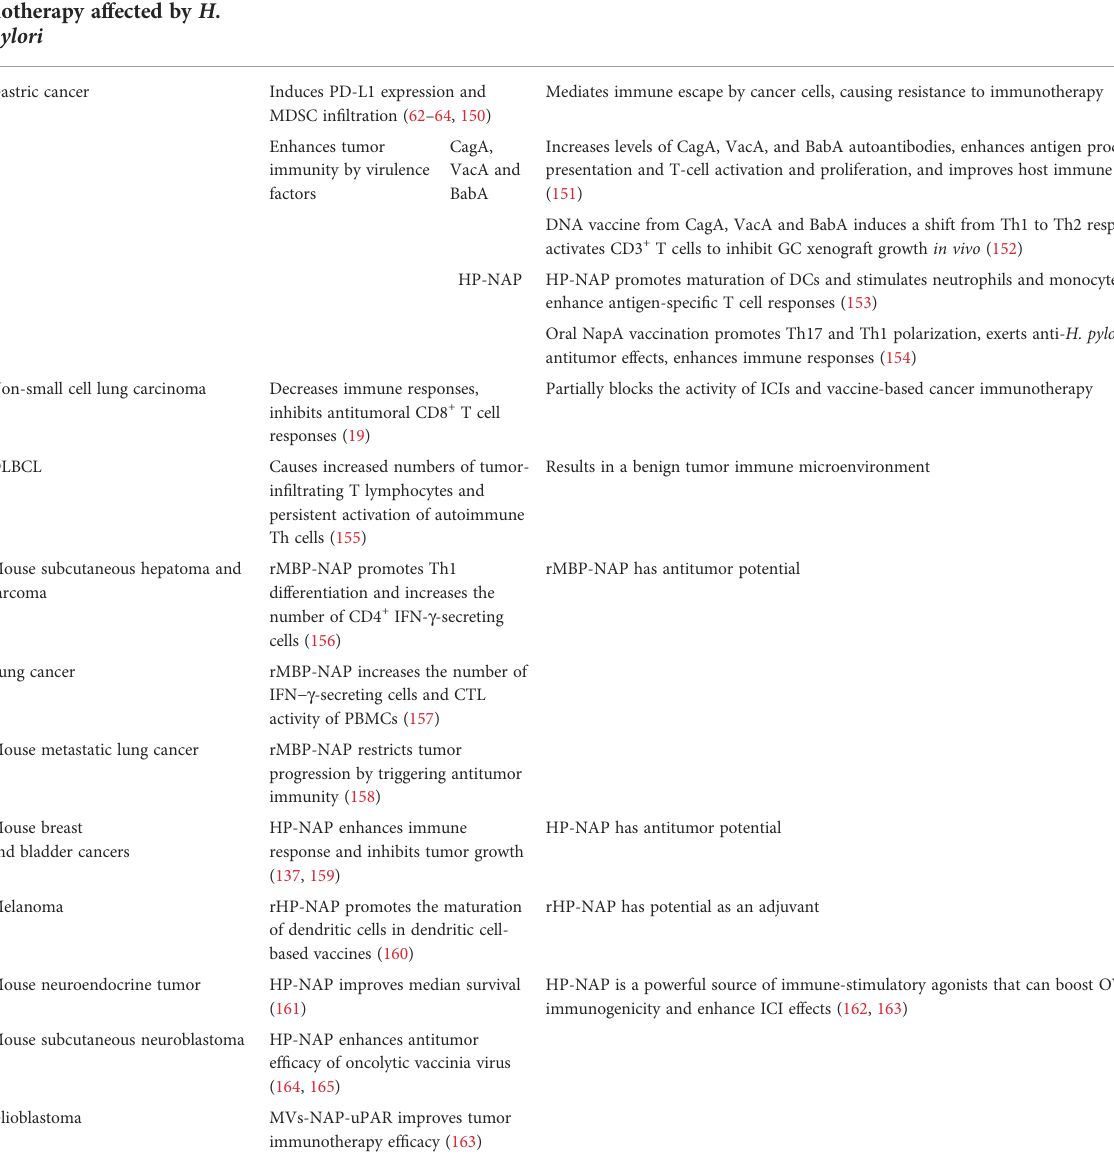
TABLE 3 Effects of H. pylori on tumor immunotherapy responses. Cancer targeted by immu- notherapy affected by